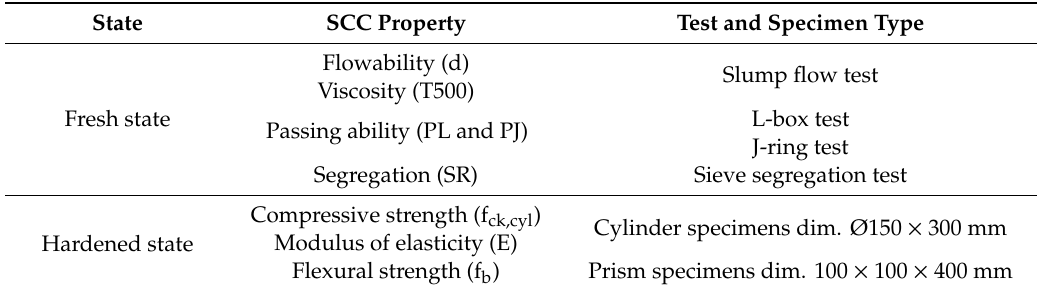
Table 5. Tested self-compacting concrete (SCC) fresh and hardened state